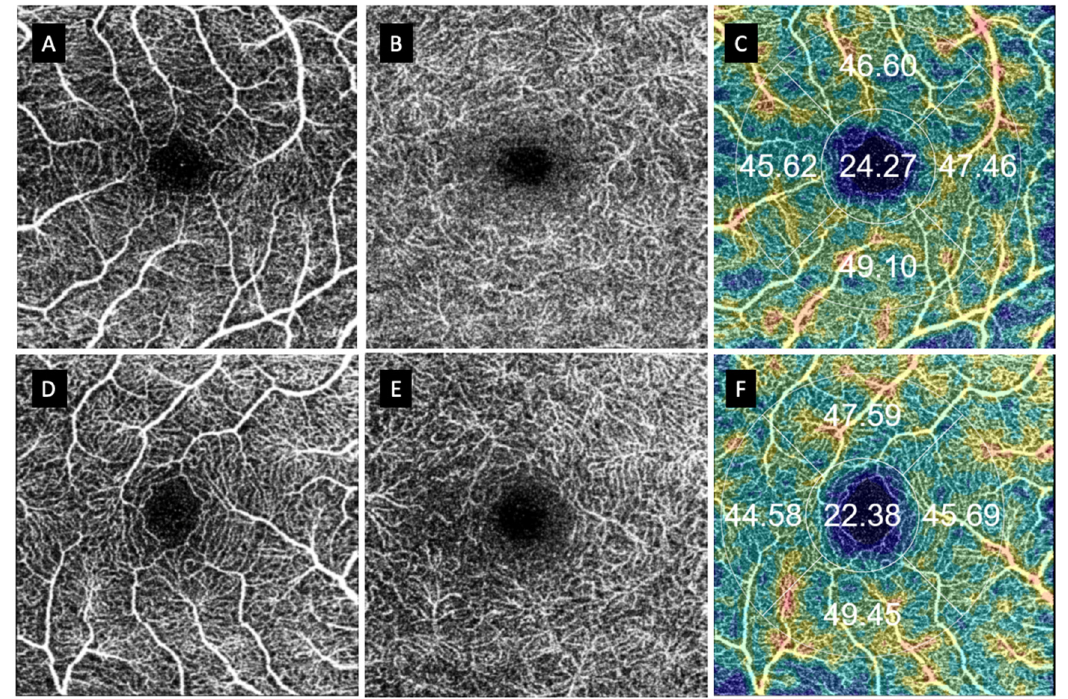
Figure 4. Anatomical finding in patients with macula-on RDD vs. their fellow eyes. ( A – C ) Macula-on RDD. ( D – F ) Fellow healthy eye. ( A , D ) represent superficial capillary plexus (SCP); ( B , E ) represent deep capillary plexus (DCP); ( C , F ) represent VD in the SCP.